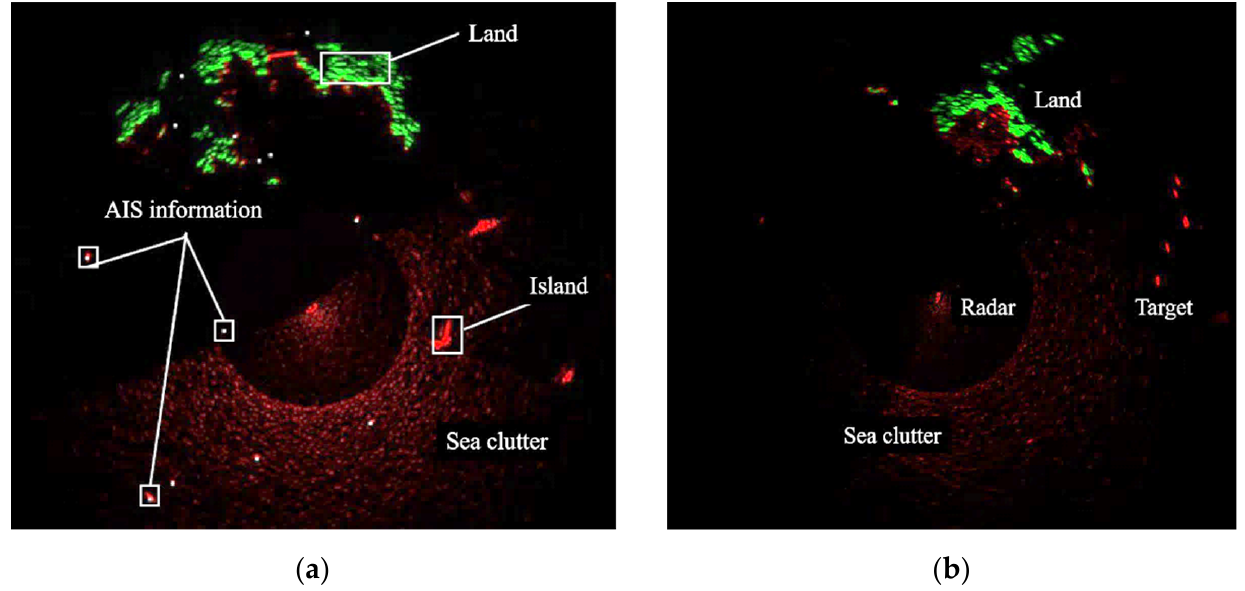
Figure 10. Characterizations of different radar PPI images: ( a ) Coastal environment; ( b ) Open sea environment.